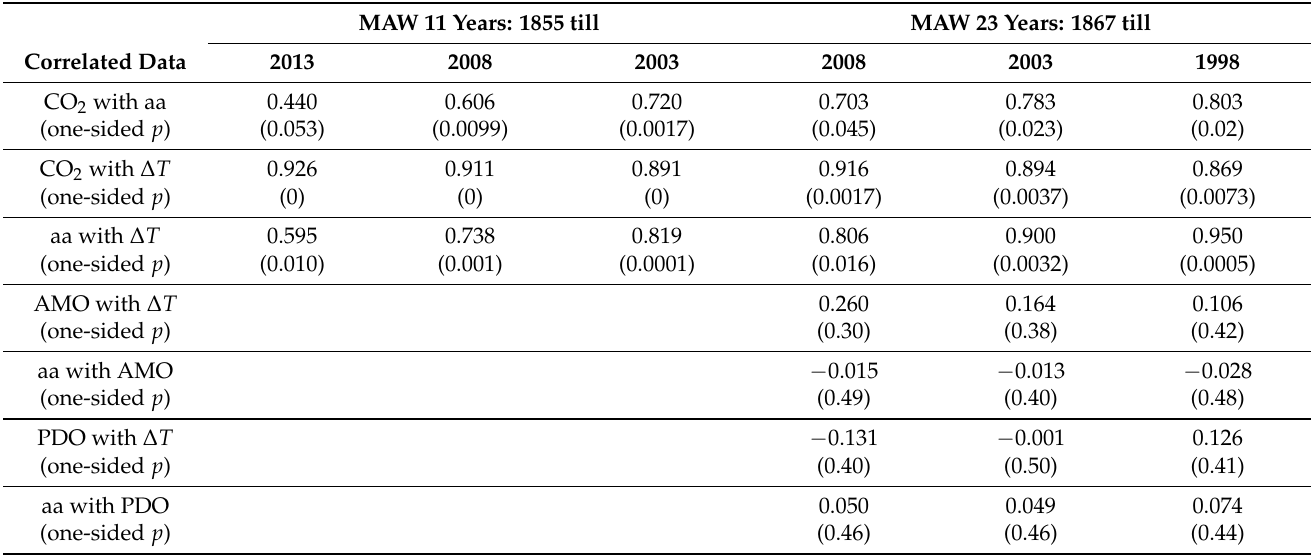
Table 1. Empirical correlation coefficients r between different datasets, each of which represents a centered moving average over 11 or 23 years. The values in parentheses indicate the (one-sided) p -values, based on the “honest” number of degrees of freedom, i.e., N y /11 or N y /23, wherein N y is the number of years. Note the large values for the correlation both between CO 2 and the aa index with ∆ T , compared to weak or barely existing correlations of the AMO and PDO index with ∆ T